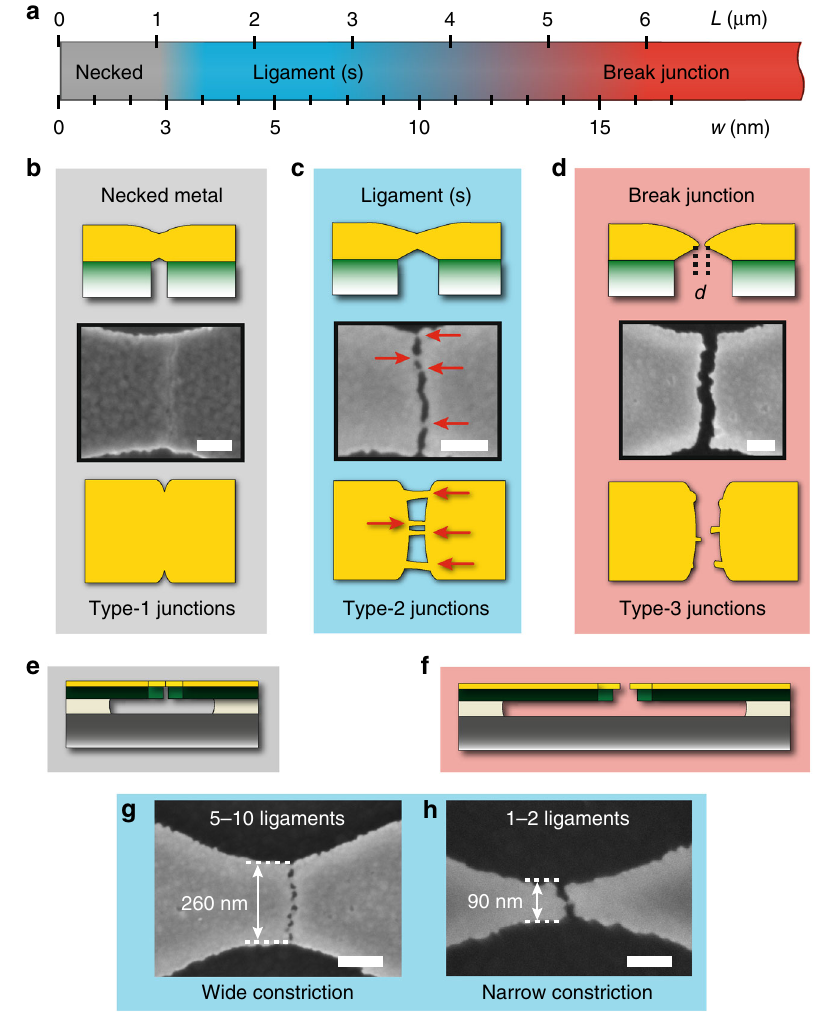
Fig. 3 Results of the pulling action on 10 nm thick gold. a Each of the 780,000 bridges that were fabricated on the silicon wafer was designed to achieve a speci fi c pulling action w , which was de fi ned by the length L of each individual bridge (see Eq. 1). The various pulling actions w resulted in three distinct outcomes for the strained sections of gold above each crack-line. b When w < 3 nm, the 10 nm thick gold only undergoes necking (type-1 junctions); SEM imaging on these junctions reveal a lighter area where the underlying crack in the TiN has propagated. c When 3 nm < w < 16 nm, nanometric voids appear in the gold, forming ligaments (indicated by red arrows) crossing the nanogap and connecting the electrodes (type-2 junctions). d When w > 16 nm, the gold ligaments break, thereby forming two electrodes separated by a distance d (type-3 junctions). e , f Cross-section schematics depicting that short bridges and consequently small w produces necked metal ( e ), whereas long bridges and large w produce break junctions ( f ). g , h Two SEM images of junctions described in c illustrate that the average number of gold ligaments depends on the width of the constriction of the bridge. Speci fi cally, the narrow break junction design in h results in 1 or 2 ligaments, and was selected for detailed electrical characterization (see Fig. 4) for its potential suitability